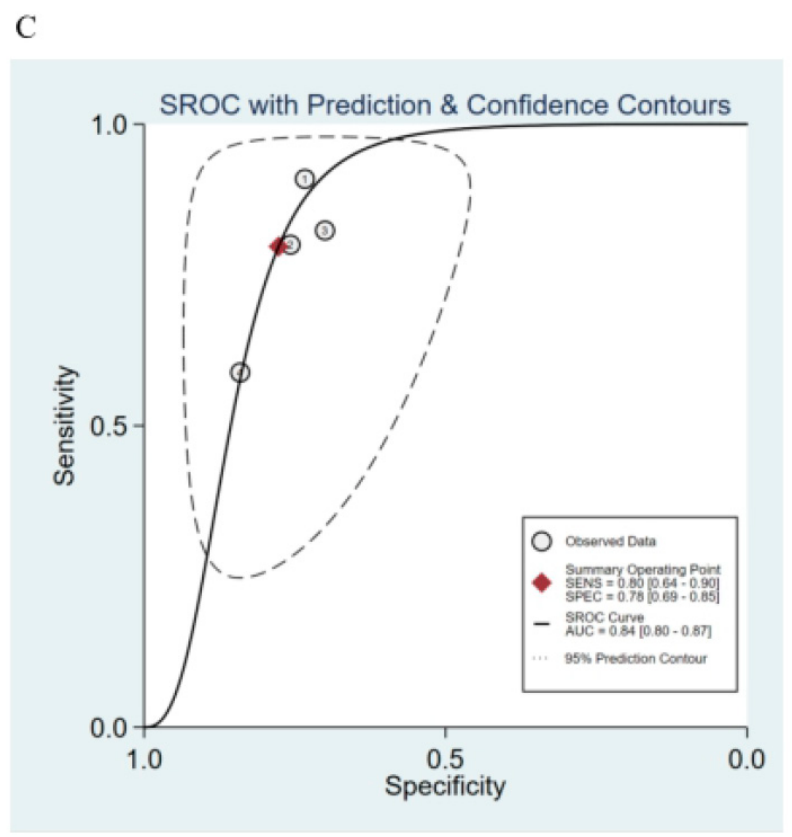
Figure 2. Forest plots of ( A ) pooled sensitivities, ( B ) specificities, and ( C ) summary receiver–operat- ing characteristic curve ( C ) of myocardial contrast echocardiography to predict major adverse car- diac events during follow-up visits [13,14,16,17].